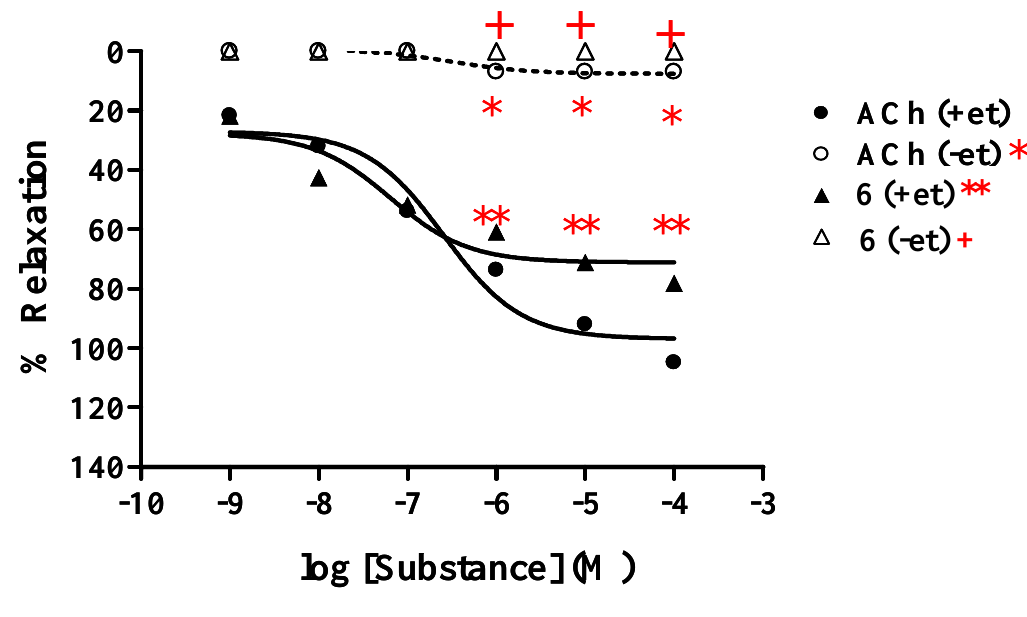
Figure 6. Effect of 6 and ACh on the vascular function of rat thoracic aorta under removal of endothelium (-et) compared with intact endothelium (+et ).